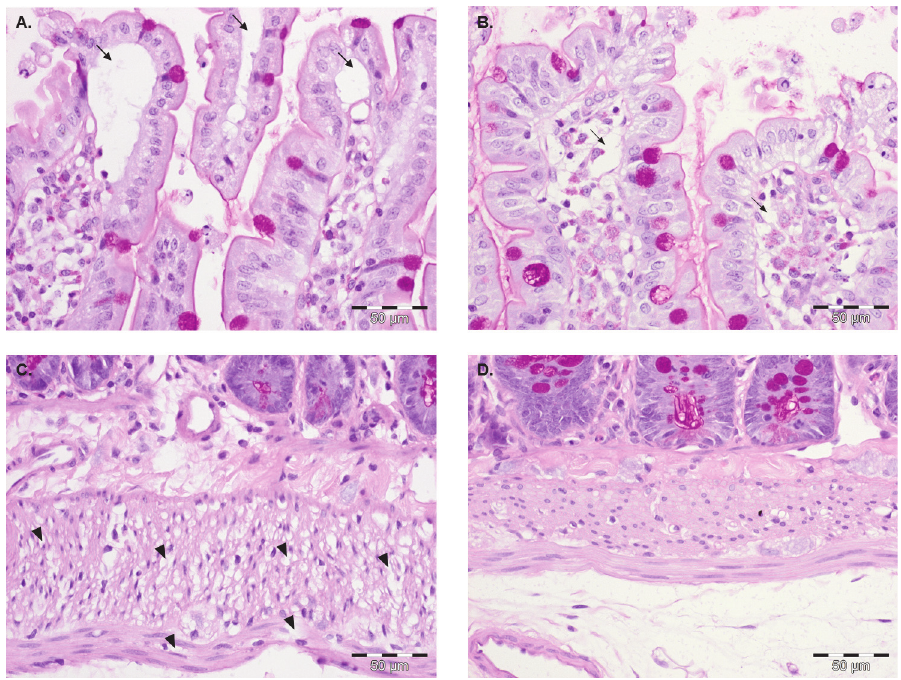
Fig 4. Histomorphology of PAF stimulated intestines pretreated with dexamethasone or quinidine. PAS-stained sections of longitudinal intestinal slices. A. Fluid accumulations at the villus tips (arrows) of PAF- stimulated intestines after pretreatment with dexamethasone (n = 1); B. Slight fluid accumulations at the villus tips (slim arrows) of PAF-stimulated intestines after pretreatment with quinidine (n = 1); C. Fluid accumulations in the intestinal muscular wall (arrowheads) of PAF-stimulated intestines after pretreatment with dexamethasone (n = 1). D. Normal morphology without fluid accumulations in the intestinal muscular wall of PAF-stimulated intestines after pretreatment with quinidine (n =